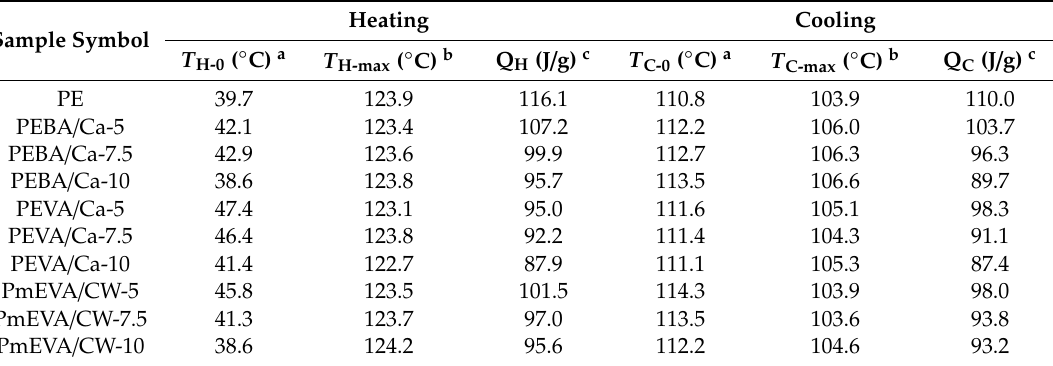
Table 3. Thermal properties (di ff erential scanning calorimeter (DSC)) of PE composites with selected MMTs and dispersing agents.